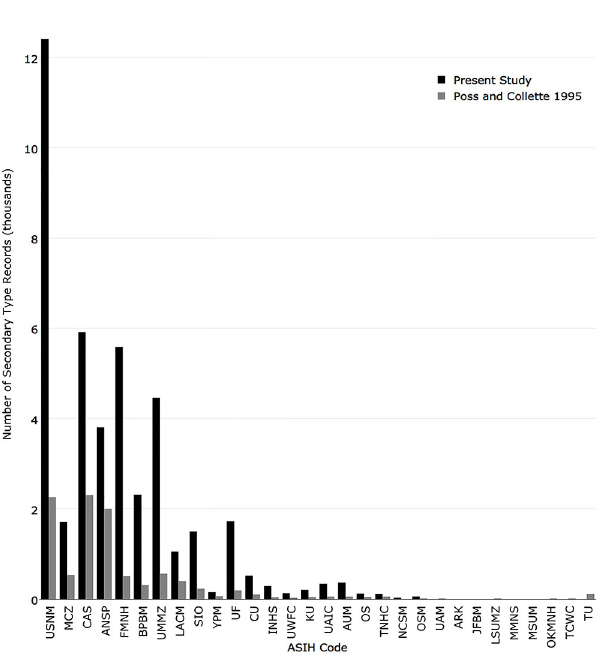
Fig 12. Comparison of the number of secondary type records currently published in iDigBio (black) with the number reported in Poss and Collette (1995) (grey).